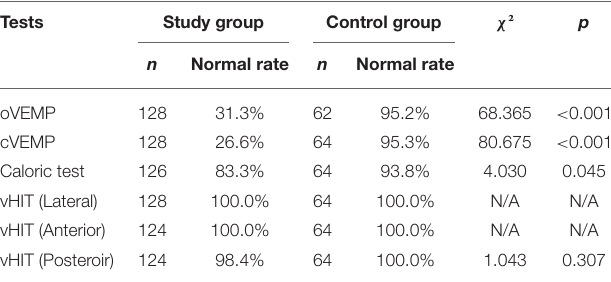
TABLE 2 | Comparison of normal rates of vestibular function tests between the control group and the study group.